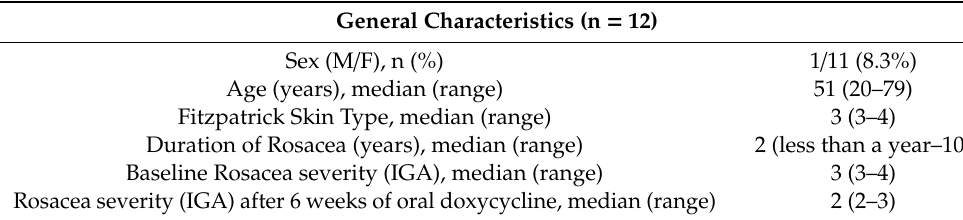
Table 1. Demographic and clinical characteristics of the study participants.